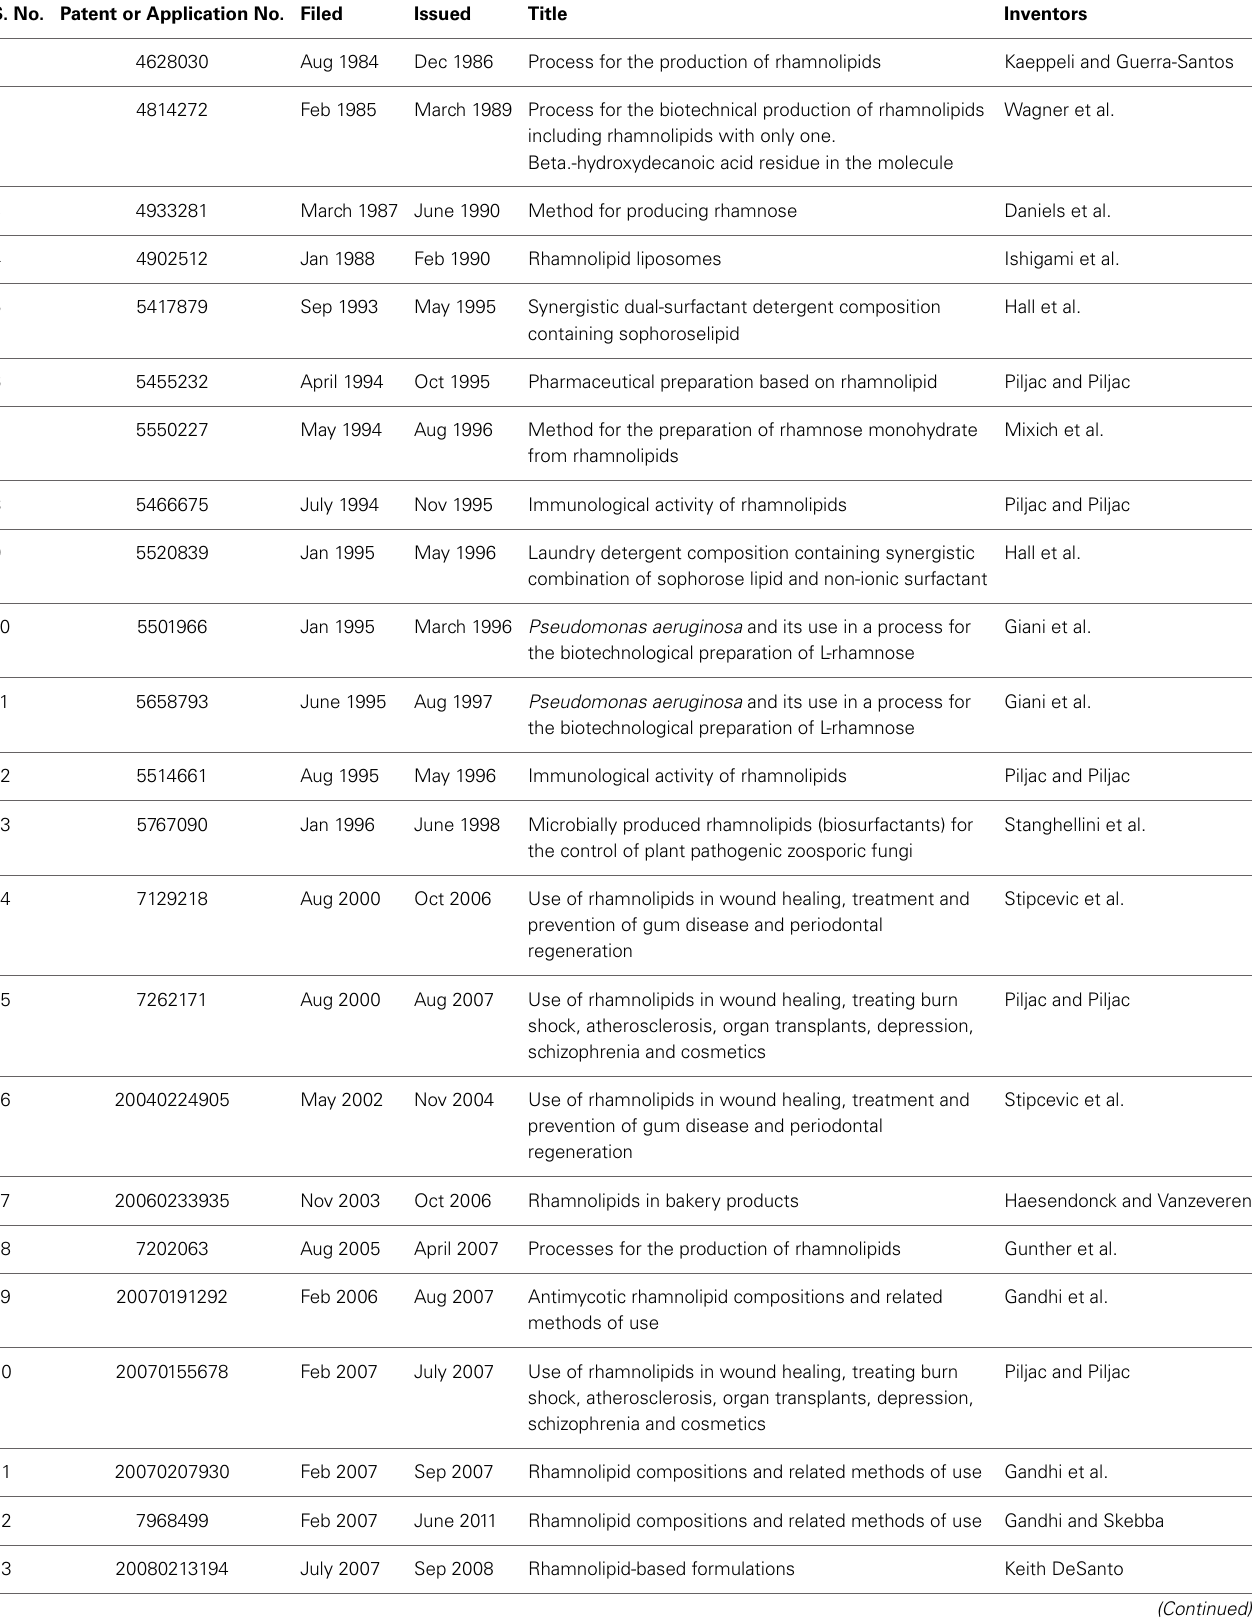
Table 3 | A timeline and the major patents and grants obtained on rhamnolipids so